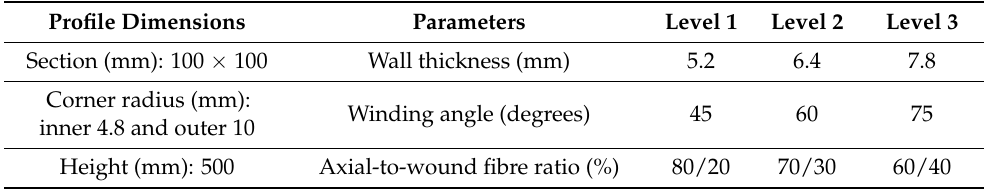
Table 2. Parameters and levels investigated in Alsaadi 2019 [94] parametric